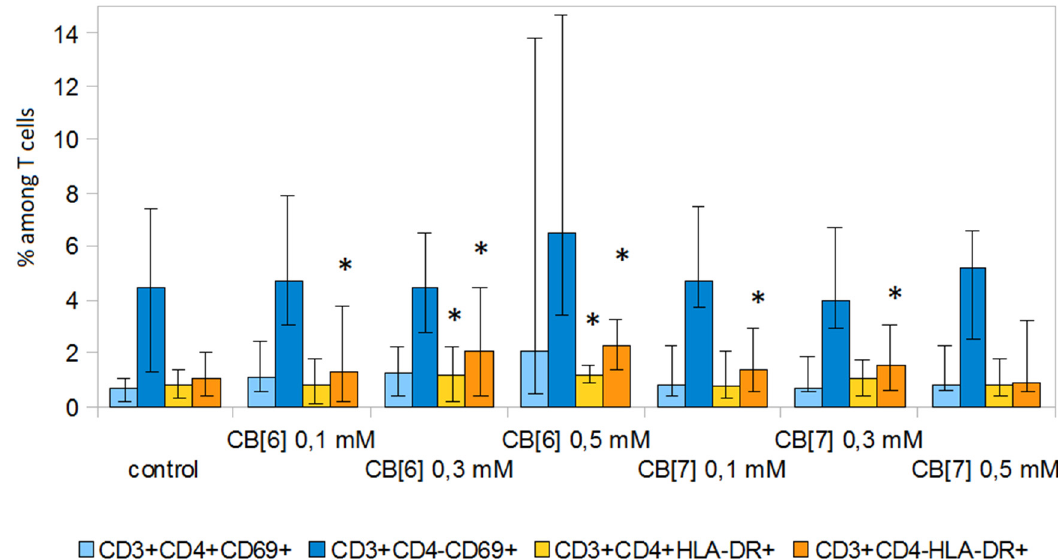
Figure 5. Effect of CB[n] on the expression of activation markers on T cells during the spontaneous proliferative activity of PBMCs. Data are presented as the median with interquartile range. (* Indicates a significant difference ( p < 0.05) vs. the control).